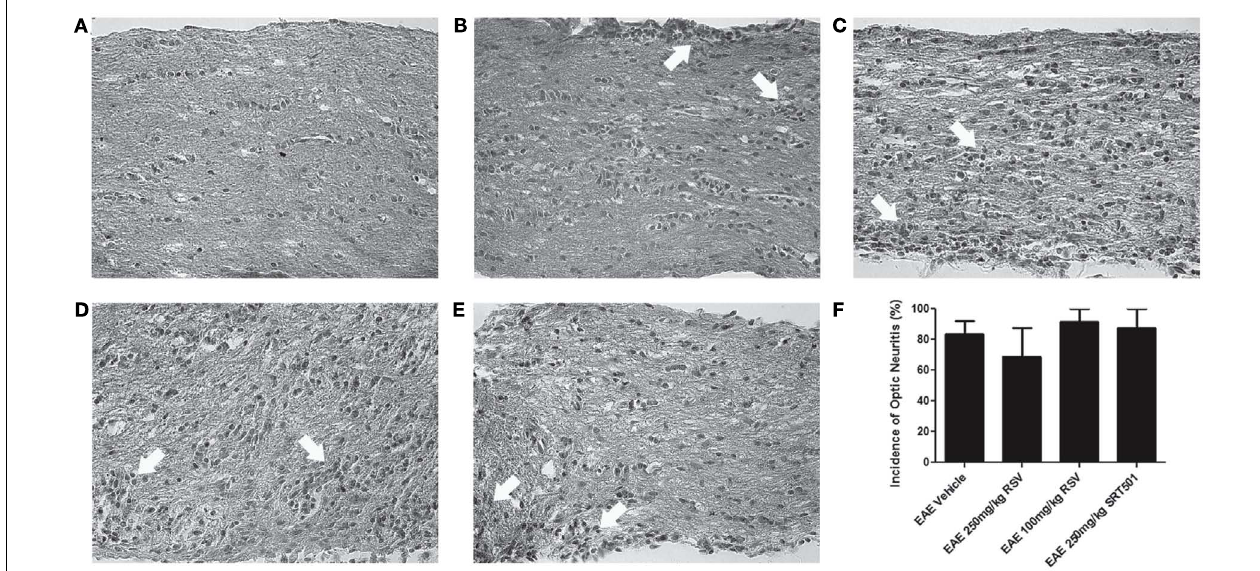
sheath. Similar inflammation (arrows) is seen in optic nerves from EAE mice treated with 100mg/kg RSV (C) , 250mg/kg RSV (D) , and 250mg/kg SRT501 (E) . (F) The percentage of inflamed optic nerves did not differ between PBS-, RSV-, or SRT501-treated EAE mice. Photos shown at original magnification × 40 (A–E)